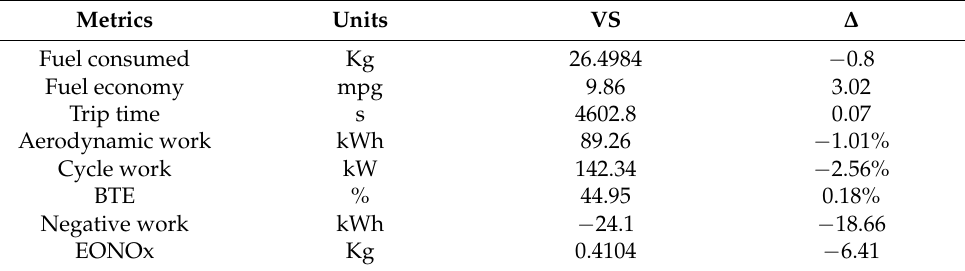
Table 3. Optimal metrics for the dynamic speed management